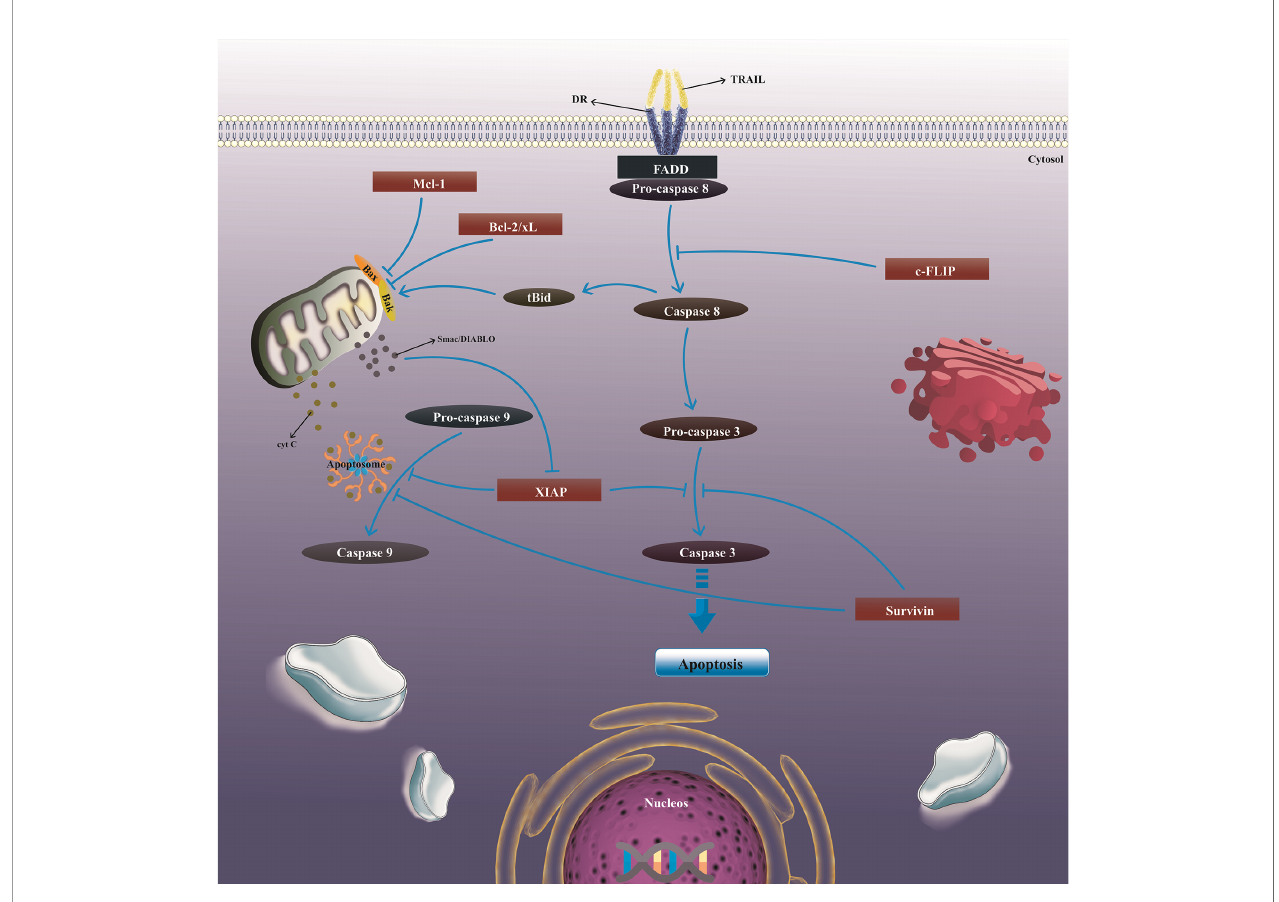
FIGURE 2 | The mechanism of TRAIL-induced apoptosis in tumor cells. TRAIL connecting to DR4 and DR5 stimulates apoptosis in both the extrinsic and intrinsic pathways following trimerization of receptors and FADD translocation and activation. However, various anti-apoptotic proteins, including c-FLIP, XIAP, Mcl-1, survivin, Bcl-2, and Bcl-xL can negatively regulate apoptosis pathways. TRAIL, Tumor necrosis factor-related apoptosis-inducing ligand; DRs, Death receptors; FADD, FAS- associating death domain-containing protein; c-FLIP, Cellular FLICE (FADD-like IL-1b-converting enzyme)-inhibitory protein; Bcl-2, B-cell lymphoma-2; Bcl-xl, B-cell lymphoma-extra large; Mcl-1, Myeloid-cell leukemia 1; XIAP, X-linked inhibitor of apoptosis; Bax, Bcl-2 associated X; Bak, Bcl-2 homologous antagonist/killer; Bid, BH3-interacting domain death